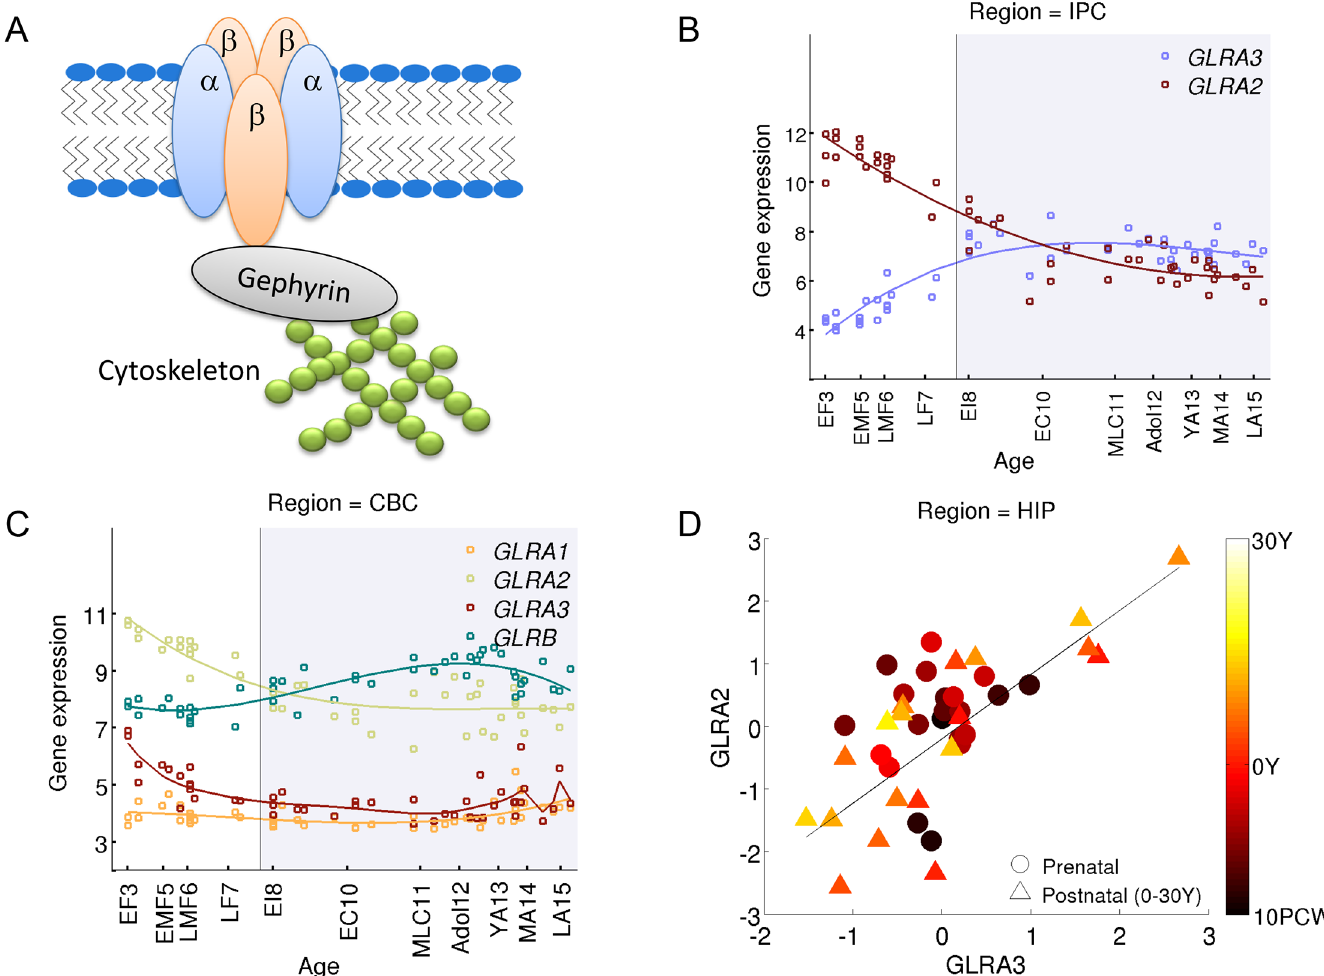
Fig 4. A novel CDV pair in the glycine receptor subunits GLRA2 and GLRA3. (A) A diagram of glycine receptor components (B) The gene expression profiles of glycine receptor subunits as measured by Kang et al. (2011) in the human posterior inferior parietal cortex (IPC). (C) The gene expression profiles of glycine receptor subunits as measured by Kang et al. (2011) in the human cerebellar cortex. (D) Subject to subject age corrected correlation within two age groups, prenatal (10PCW-birth), and postnatal